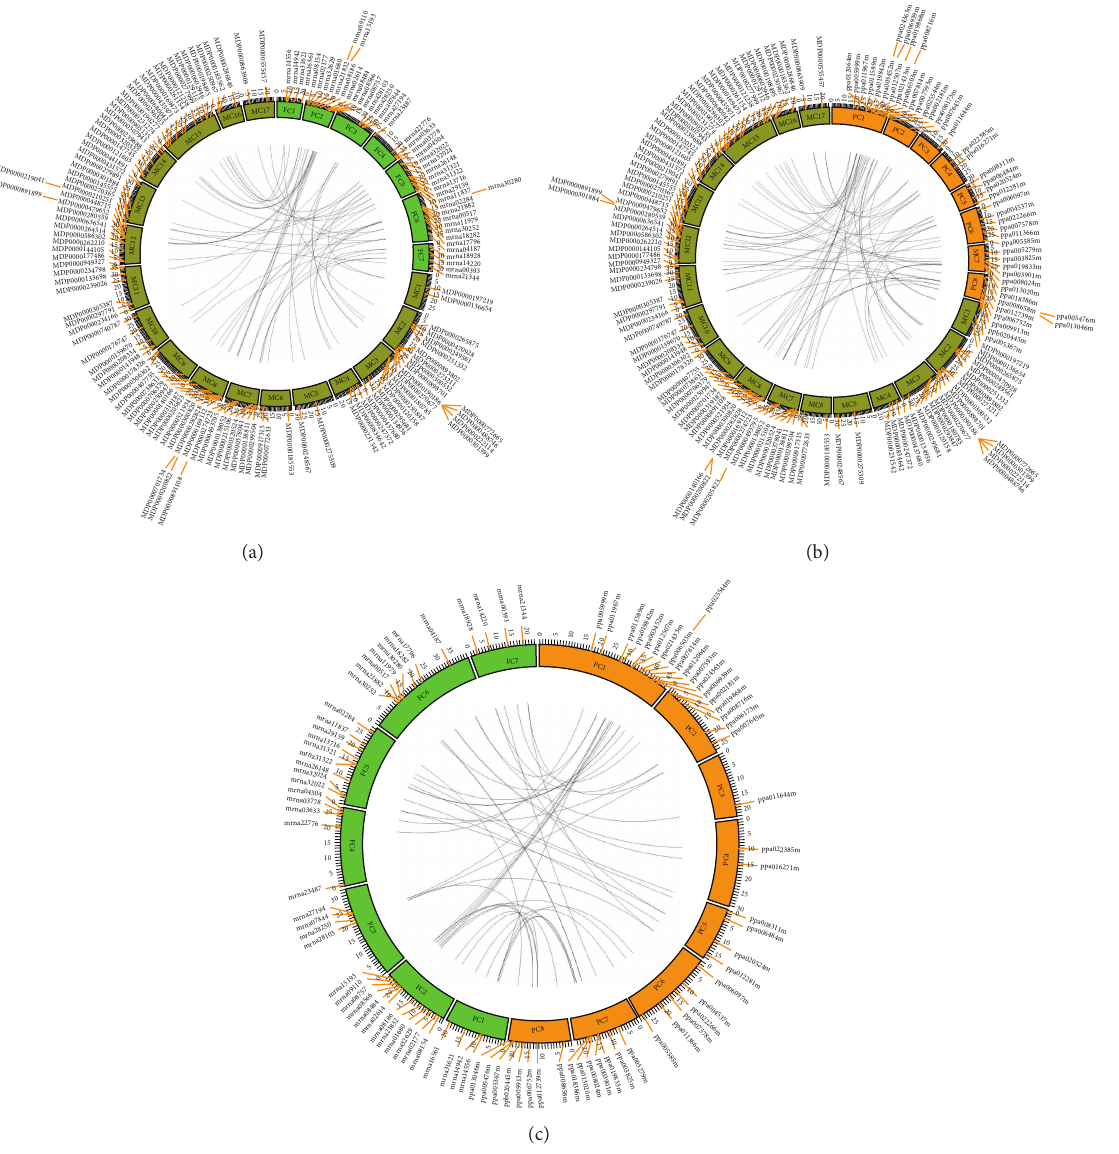
Figure 5: Evaluation of orthologous bZIP genes between strawberry, apple, and peach. (a) Seven strawberry (FC1 to FC7) and seventeen apple chromosome (MC1 to MC17) maps are based on the orthologous pair position and demonstrate a highly conserved syntenic relationship. (b) Seventeen apple chromosome (MC1 to MC17) and peach (PC1 to PC8) maps are based on the orthologous pair positions and demonstrate highly conserved synteny. (c) Seven strawberry (FC1 to FC7) and peach (PC1 to PC8) maps are based on the orthologous pair positions, and demonstrate highly conserved